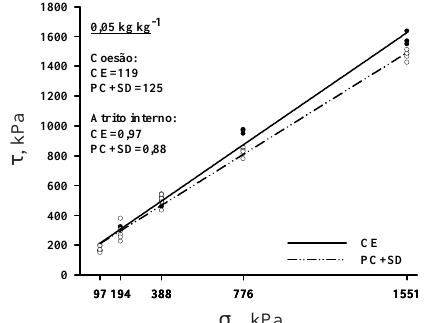
Figura 6. Relação linear simples entre tensão normal ( σσσσσ ) e tensão cisalhante ( τττττ ) do Latossolo n Vermelho distrófico, sob cerradão (CE), preparo convencional (PC) e semeadura direta (SD), com seus respectivos parâmetros de intercepto de coesão e coeficiente de atrito, para a umidade de 0,05 kg kg -1 .